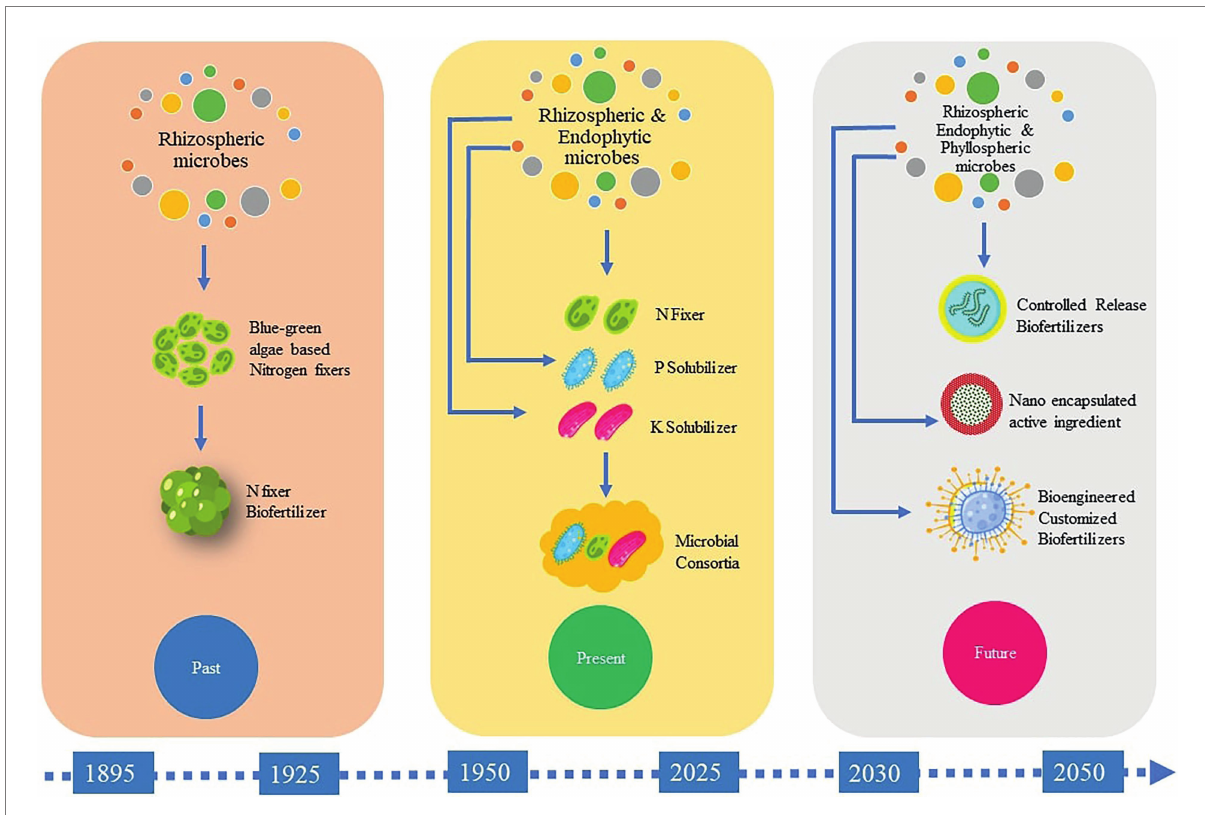
FIGURE 5 Schematic representation of the past present and future of biofertilizer